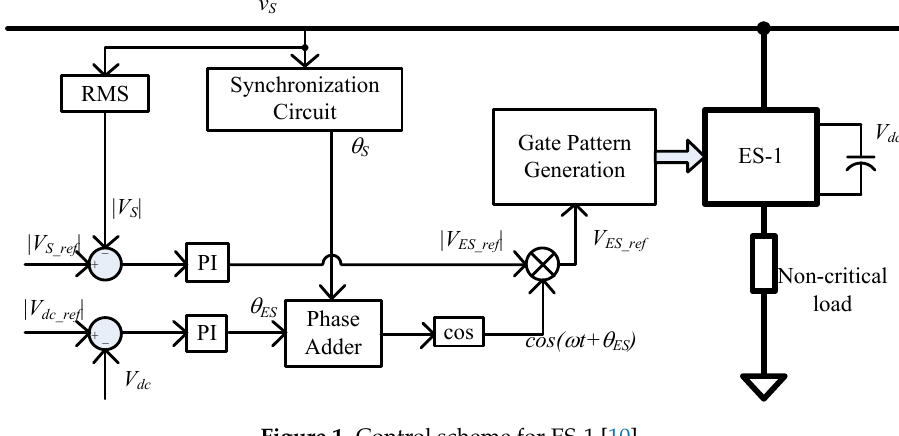
Figure 1. Control scheme for ES-1 [10].